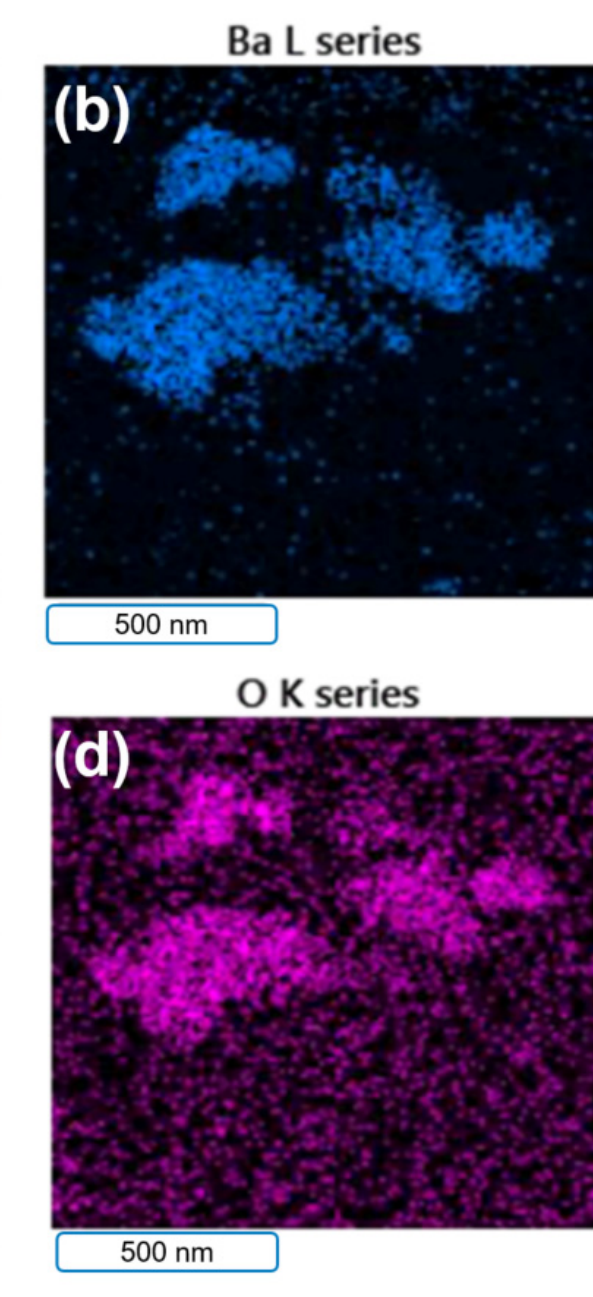
Figure 4. Electron images of 5 wt% rGO–B–epxoy. ( a ) secondary-electron image, ( b ) Ba elements mapping, ( c ) oxygen element mapping, ( d ) sulfur element mapping.